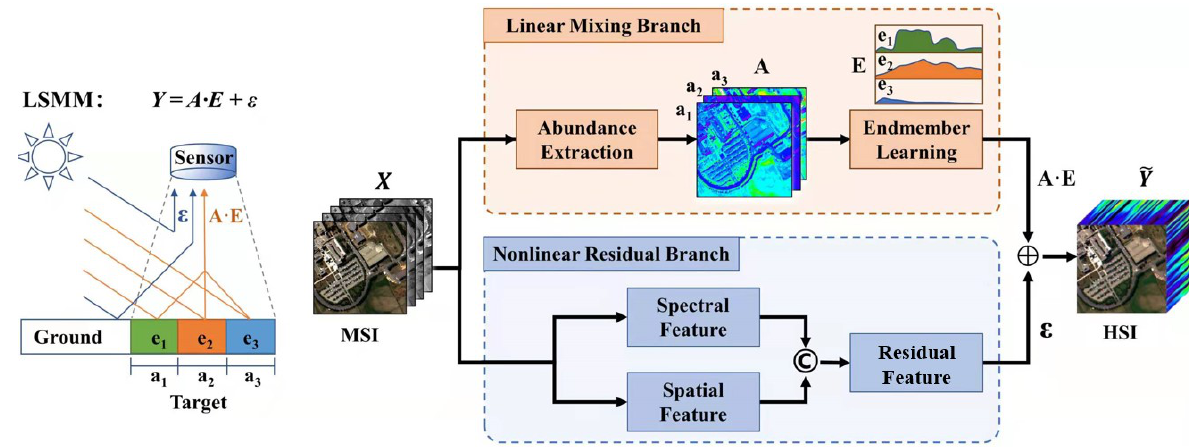
Figure 1. The spectral mixing process and inspired double-branch network structure.